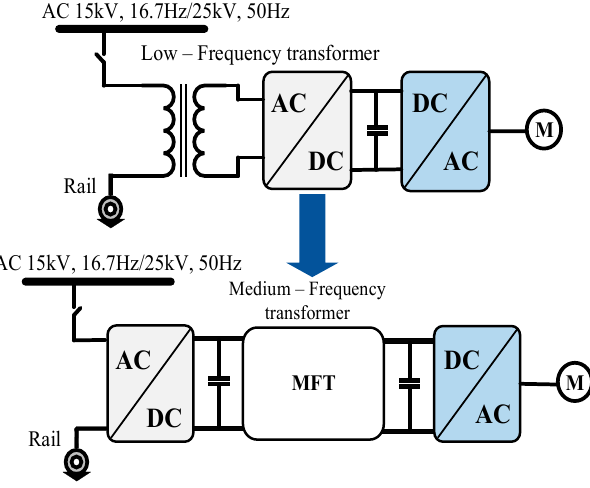
Figure 4. SST-based tractions system.